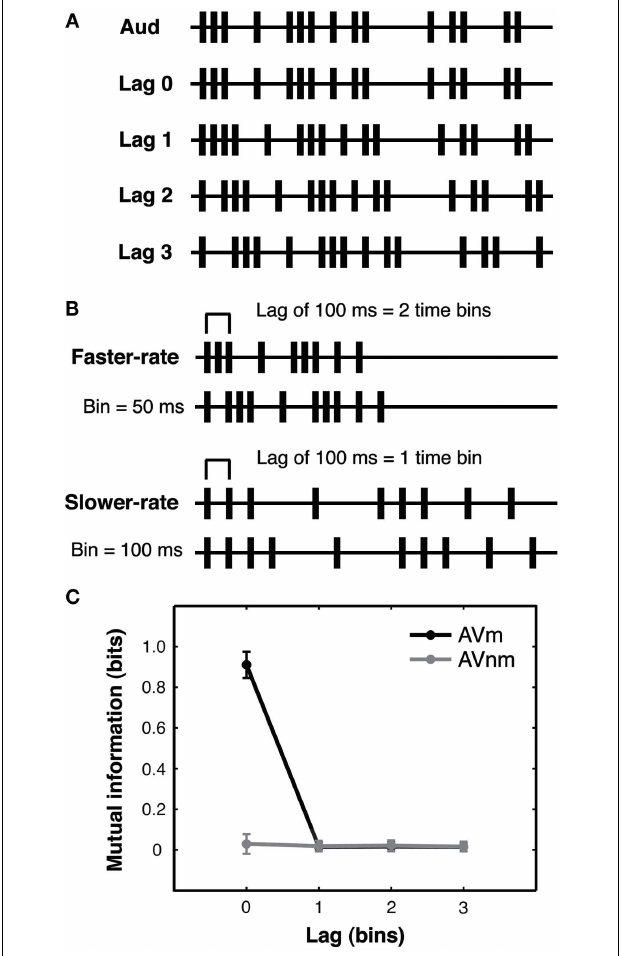
FIGURE 2 | Experiment 1: lagged stochastic event streams with varied presentation rate. (A) Auditory streams (Aud) were generated using a stochastic point process with 1/3 probability that an auditory event would occur in each fixed-duration timebin. Matching visual streams (Lag 0–3) were identical to the auditory stream in temporal pattern and were either synchronous with the auditory stream (Lag 0) or could be delayed or advanced by 1–3 timebins (Lag 1–3, audition-leading-vision (AV) condition shown). Lagged events that exceeded the trial duration were looped back to the beginning of the stream to eliminate any gaps in the stimulus caused by lagging and to equate the number of events in the streams. Non-matching visual streams (not shown) were generated by shuffling the ISIs of matching streams (see text). All streams contained added initial and final events to equate stream onset and offset across streams. All lagged conditions were equated for the number of (coincidentally) synchronous events generated by the binned stochastic procedure, see main text. Example event streams are shown truncated here for brevity. (B) In the faster-rate condition, timebins were 50ms and streams lasted 2.4s, while in the slower-rate condition (presented at half that rate), timebins were 100ms and streams lasted 4.8s.Thus, a 100ms time lag corresponded to a lag of two timebins in a faster-rate trial but only one timebin in a slower-rate trial. Preserving the number of possible events across rate conditions equated the information (entropy) carried by the two types of streams. Altogether, these stimuli allowed investigation of the effect of stream presentation rate for lags of identical duration and for streams with identical levels of information (see main text). Example auditory (upper stream) and matching visual (lower) stream timelines are illustrated here for each